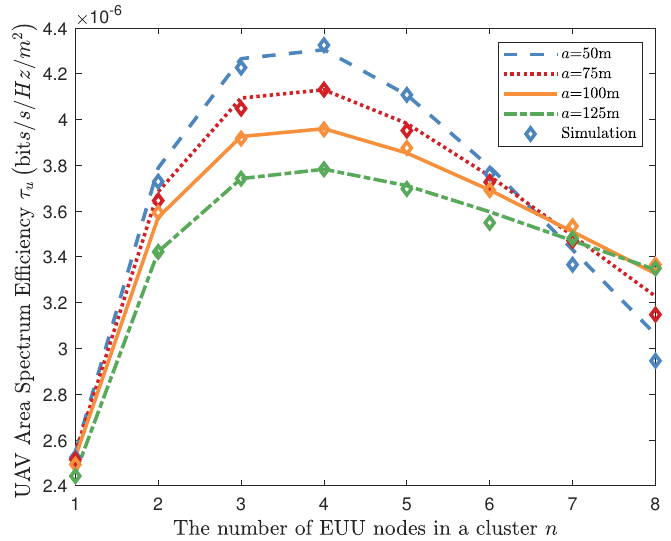
Figure 5. The area spectrum efficiency of the UAV, τ u , versus the number of EUUs within a cluster n with different cluster radius a ; SINR threshold is γ u = − 5 dB; the transmit power of EUUs is 10 dBm.